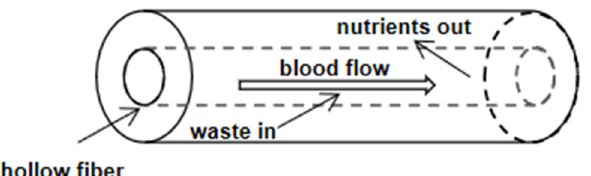
Figure 3. Blood capillary: the blood flows through the capillary and nutrients are delivered to the tissue while wastes are removed.